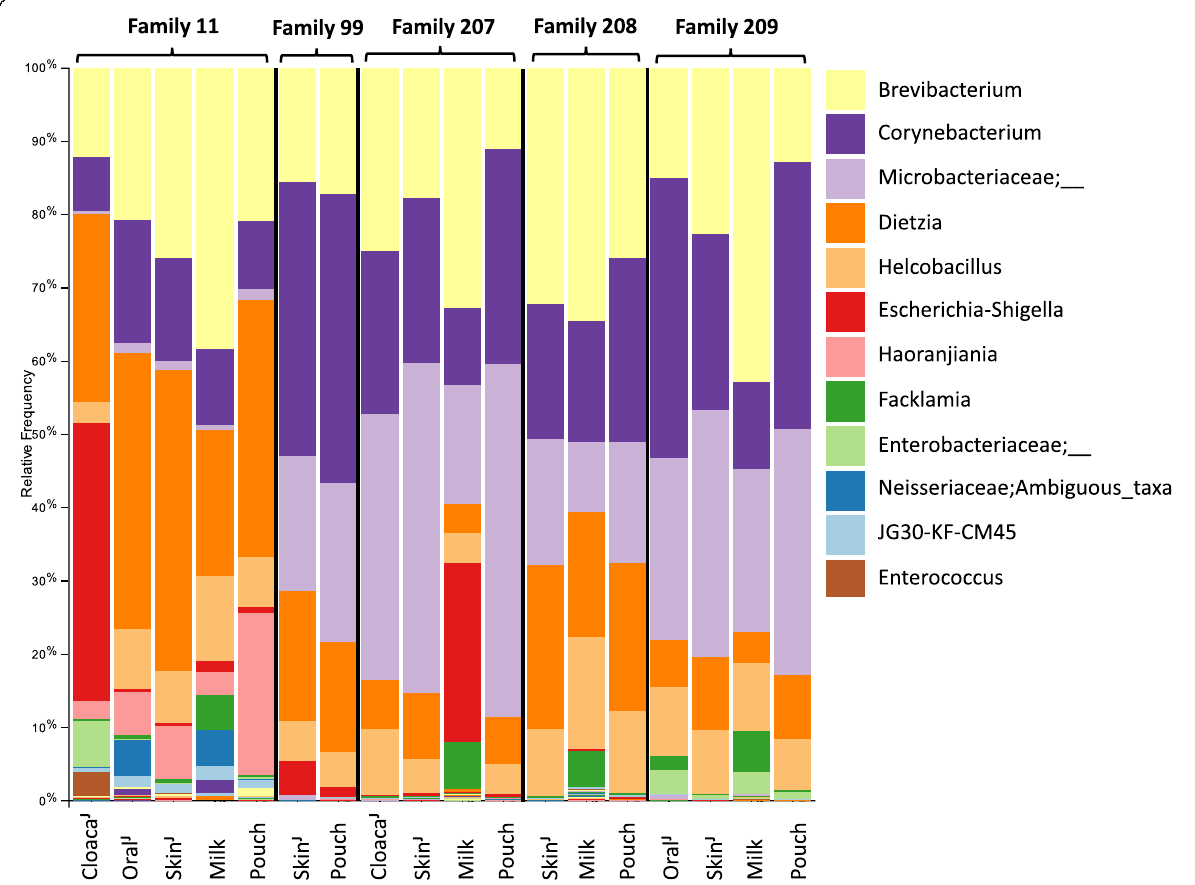
Fig. 7 Bar chart showing the genus-level relative abundance of microbial communities found in the different types of SHNW joey samples ( J ), milk samples and the pouches of the mother. Each column represents a sample belonging to a specific individual. The family groupings include the samples from a mother and its joey. Estimated joey ages are ~ 168, ~ 28, ~ 37, ~ 73 and ~ 78 days, following the order of family groupings in the figure. The legend notes the twelve most abundant taxa, some of which could only be classified to family level